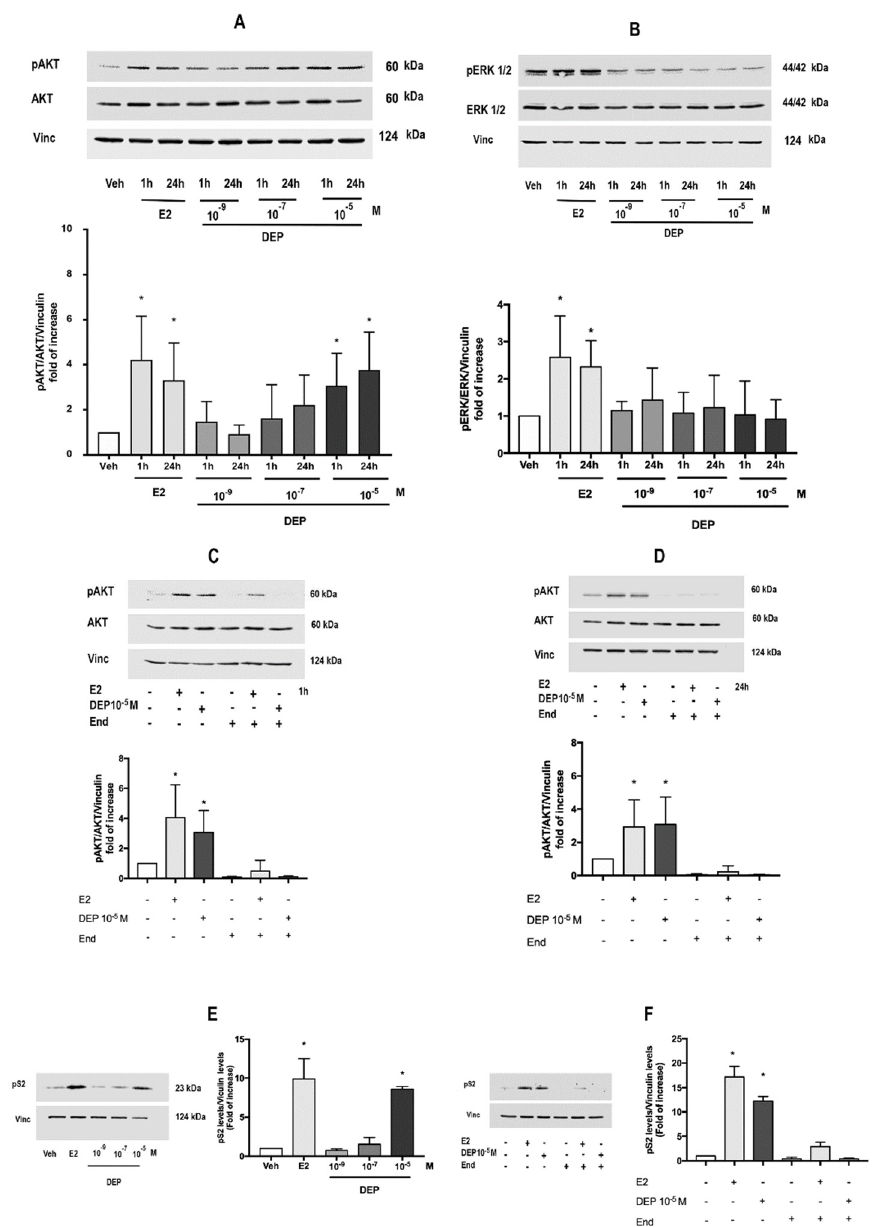
Figure 2. DEP activates nuclear and extra-nuclear rapid ER α signals. DEP dose-dependent effect on phosphorylation of AKT ( A ) and ERK1/2 ( B ) analyzed at short (1 h) and long (24 h) time exposures. Data show the Western blot image representative of at least four different experiments ( upper panel ) and the densitometric analysis ( bottom panel ). Western blot analysis of pAKT levels ( upper panel ) and densitometric analysis ( bottom panel ) in MCF-7 treated with DEP 10 − 5 M for 1 h ( C ) or 24 h ( D ) with or without cell pre-treatment with specific ER α inhibitor endoxifen (End; 10 − 6 M, 1 h before). Western blot ( left panel ) and corresponding densitometric analysis ( right panel ) of the E2-responsive protein pS2 in MCF-7 cells treated for 24 h with a dose curve of DEP (10 − 9 , 10 − 7 , 10 − 5 M) ( E ) or with DEP 10 − 5 M in the presence or absence of End (10 − 6 M, 1 h pre-treatment) ( F ). E2 in the presence and/or absence of End pre-treatment was used as internal positive control throughout all the experiments. The amount of protein was normalized in comparison with vinculin levels or with total AKT or total ERK1/2 and vinculin levels. Data are means ± SD of at least four experiments. p < 0.01 was determined by the ANOVA test followed by the Bonferroni post-test vs. Veh (-,-,-)